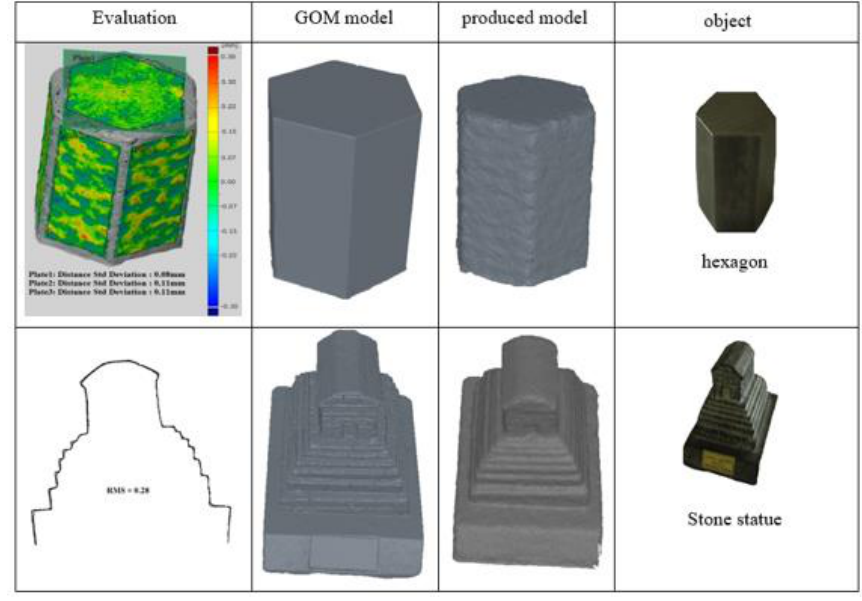
Figure 5-Comparing the point clouds generated with the proposed system and the GOM laser